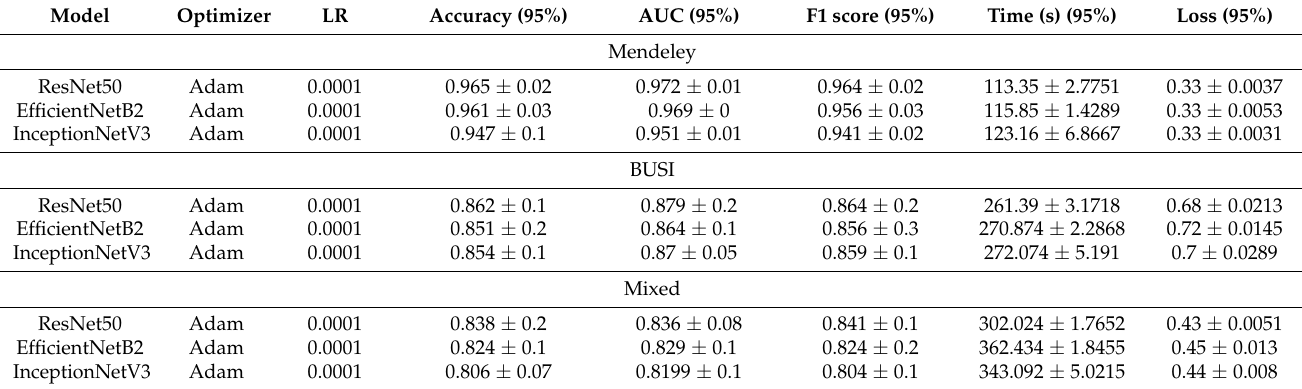
Table 6. Performance of CNN-based transfer-learning models. BUSI, breast ultrasound image dataset; LR, learning rate; s, seconds; AUC, area under receiver operating